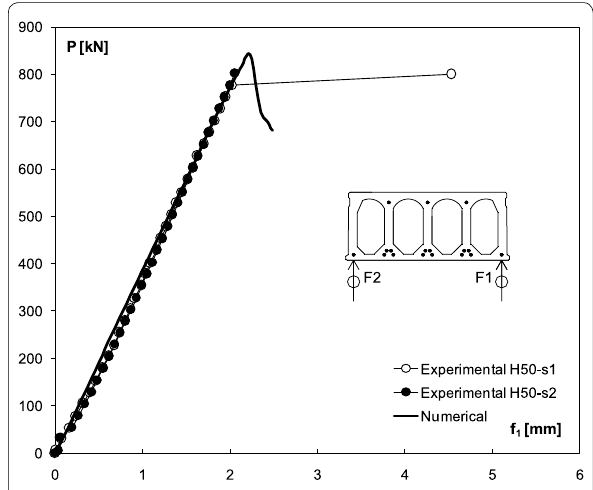
Fig. 15 Shear tests on specimens H50-s1 and H50-s2: comparisons between experimental and numerical results in terms of applied load P versus deflection under the loading point f 1